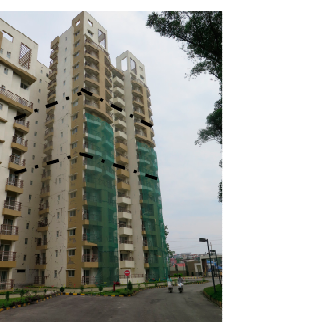
Table 6. Modal analysis results: model with infill masonry walls (damaged) – Model 3.